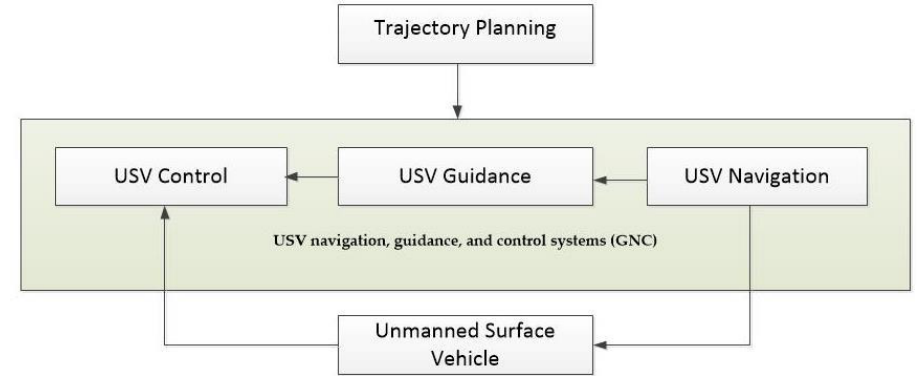
Figure 7. Interaction among GNC and vehicle.